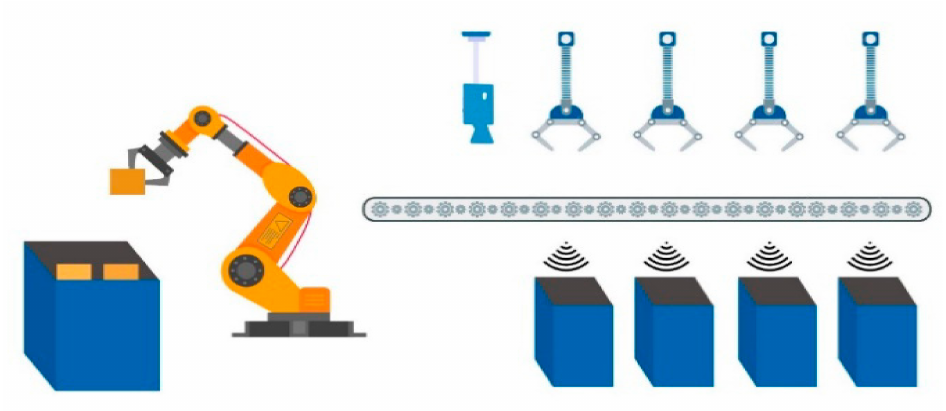
Figure 1. Graphical representation of picking waste items from the basket.